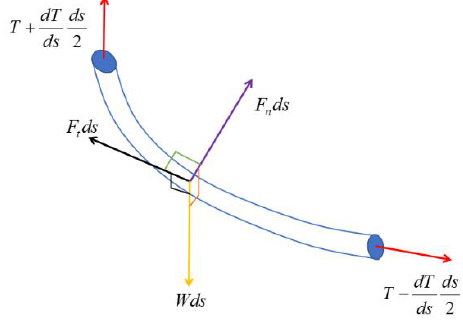
Figure 10. Forces acting on a segment of the UC.